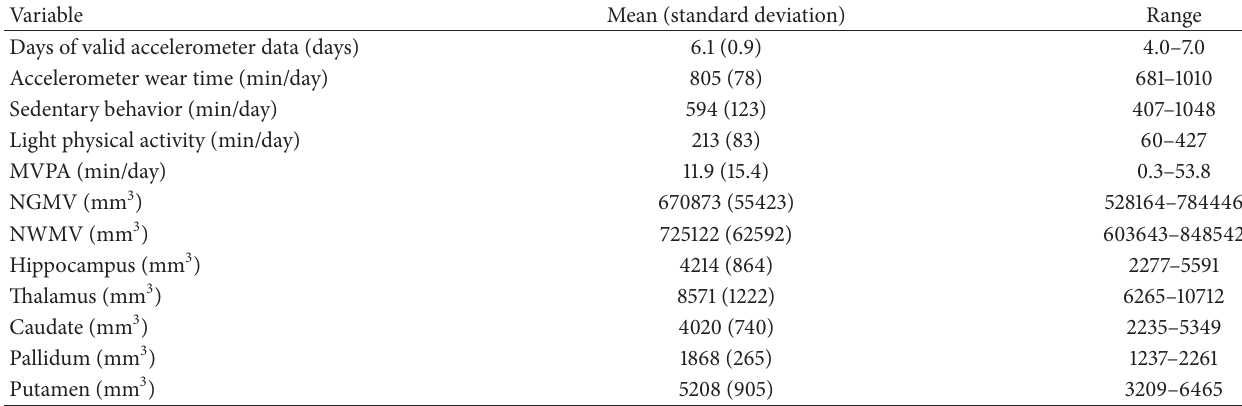
Table 1: Descriptive statistics for accelerometry, levels of physical activity, and scaled composite volumes of normalized brain volume measures in 39 persons with